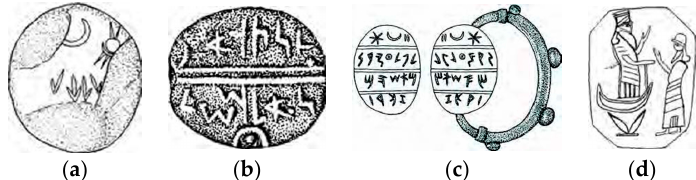
Figure 7. Seals with astral symbols: ( a ) ʿ Amman 53; ( b ) Tall al- ʿ Umeiri 39; ( c ) Umm Udeina 1; ( d ) ʿ Amman 5.